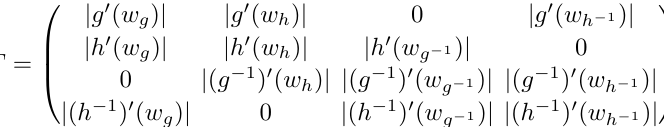
Figure 3. An example of computing the transition matrix for McMullen’s algorithm, in the case of a Kleinian group freely generated by two loxodromic elements g; h , so that C (cid:0) is a genus two (cid:3) = surface. In the (cid:12)gure, we have drawn a fundamental domain for (cid:0), the exterior of the four outermost 1 , h 1 are not shown in their entirety). Break the limit set into circles (those corresponding to g (cid:0) (cid:0) 1 ; h 1 corresponding the four pieces E (cid:13) contained in each of these circles, labelled by (cid:13) = g; h; g (cid:0) (cid:0) to the element of the group that maps the fundamental domain to the interior of the circle, and choose points w (cid:13) 2 E (cid:13) , for example the attractive (cid:12)xed point of (cid:13) . The piece of the limit set E g 1 , which are can be broken up into three disjoint pieces, inside the circles labelled g 2 , gh and gh (cid:0) the images under g of E g , E h and E respectively. The scalings of these limit sets under the h (cid:0) 1 action of g go into the top row of the transition matrix: